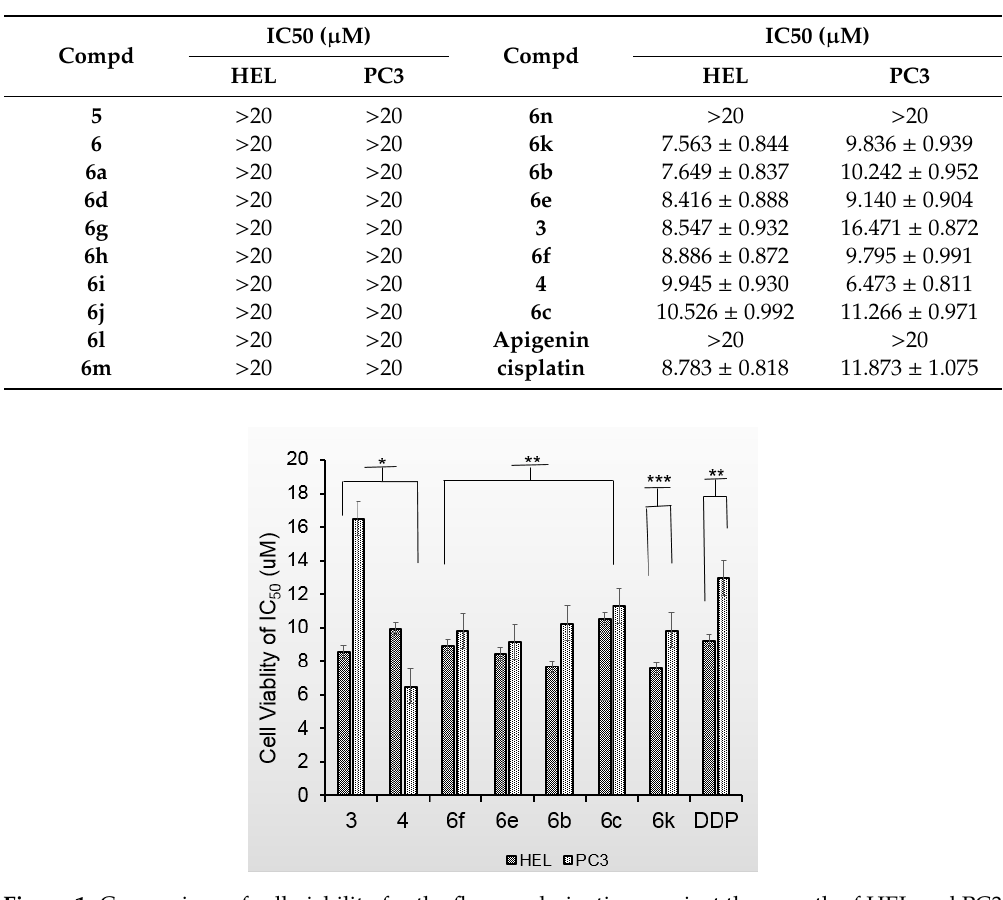
Figure 1. Comparison of cell viability for the flavone derivatives against the growth of HEL and PC3 cell lines (* p < 0.01).